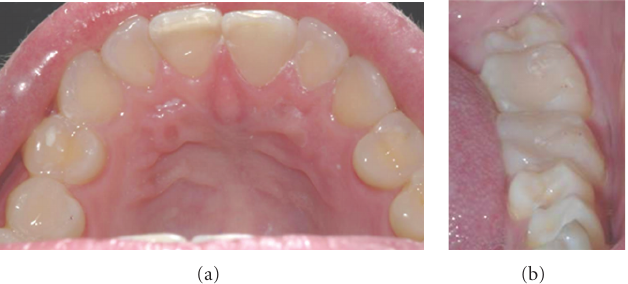
Figure 5: Biologically pragmatic treatment of erosion using direct resin composite in a 23-year-old female (compare to Figure